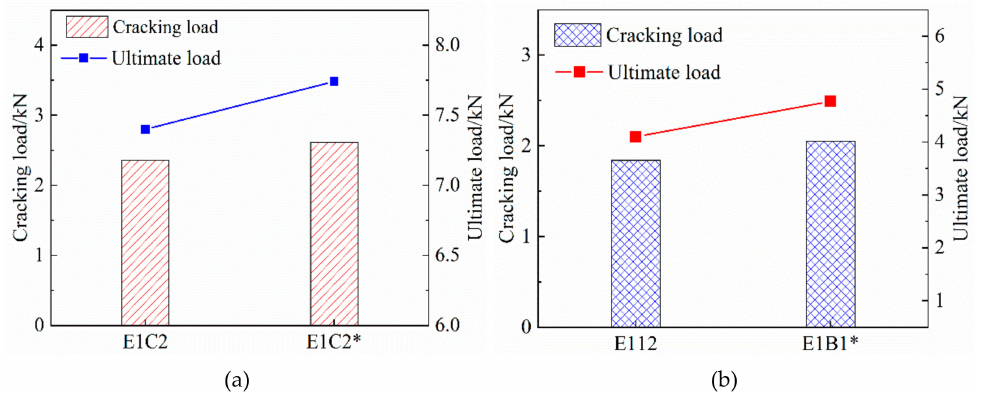
Figure 8. Effect of FRP grid surface impregnated with adhesive sand treatment on the tensile properties of specimens. ( a ) CFRP grid surface sticky sand treatment, ( b ) BFRP grid surface sticky sand